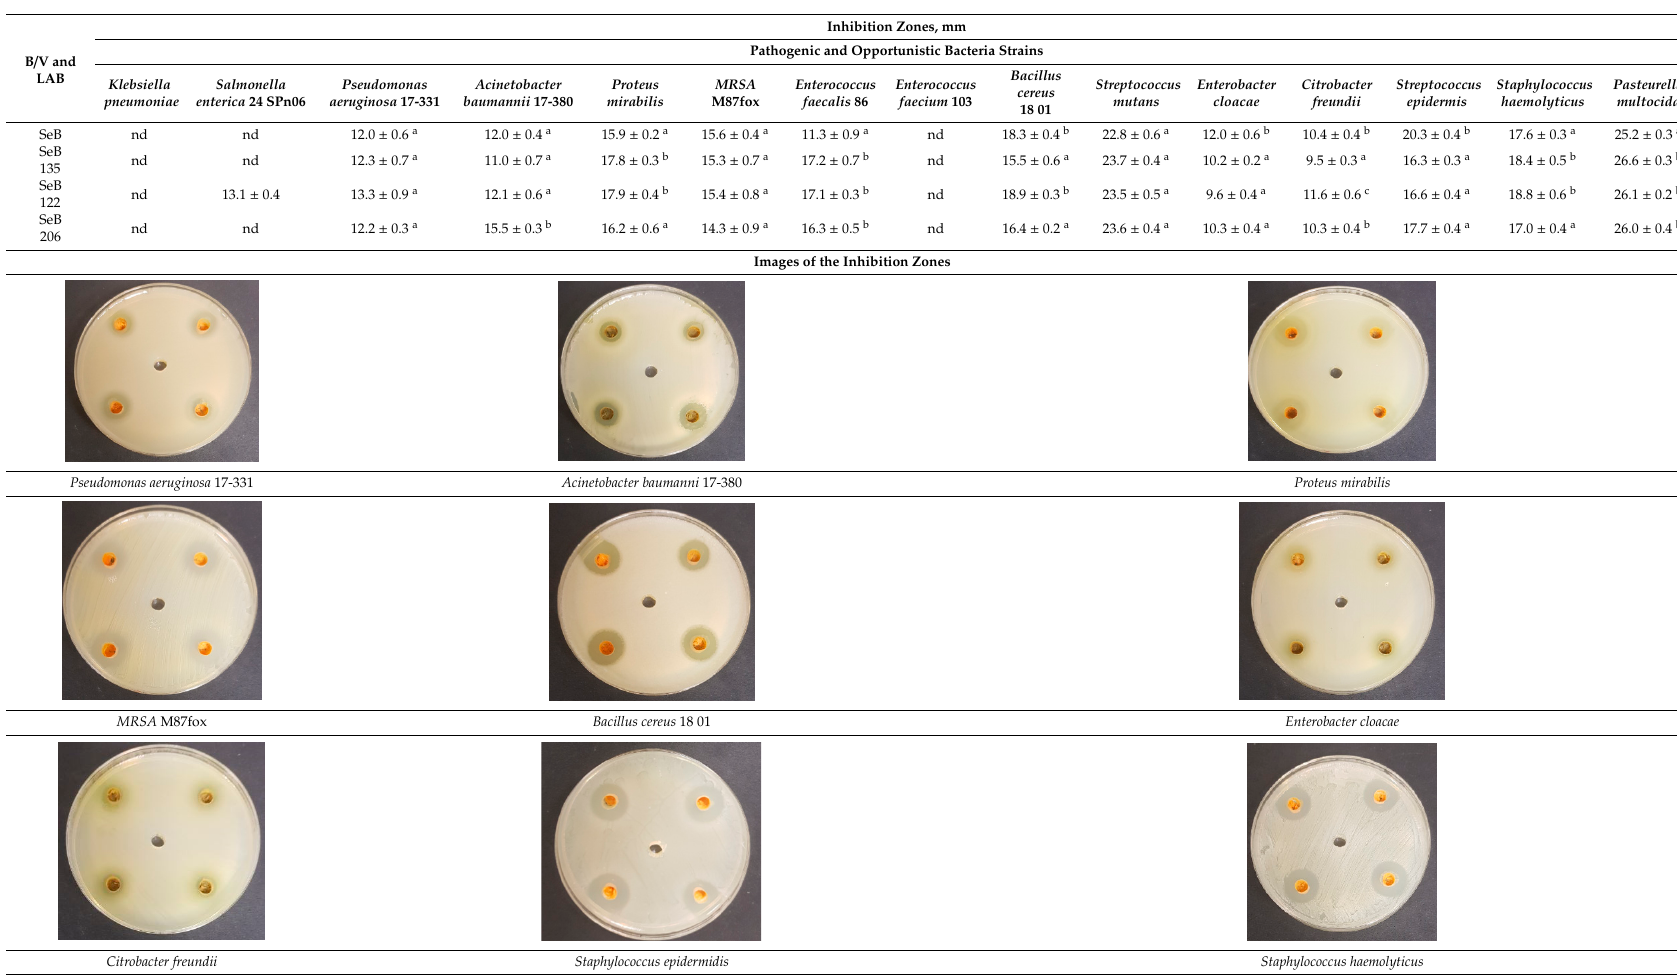
Table 4. Inhibition zones (mm) of pure sea buckthorn pomace and beverages against pathogenic opportunistic microorganisms.